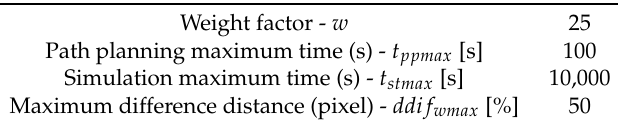
Table 2. Weight normalization